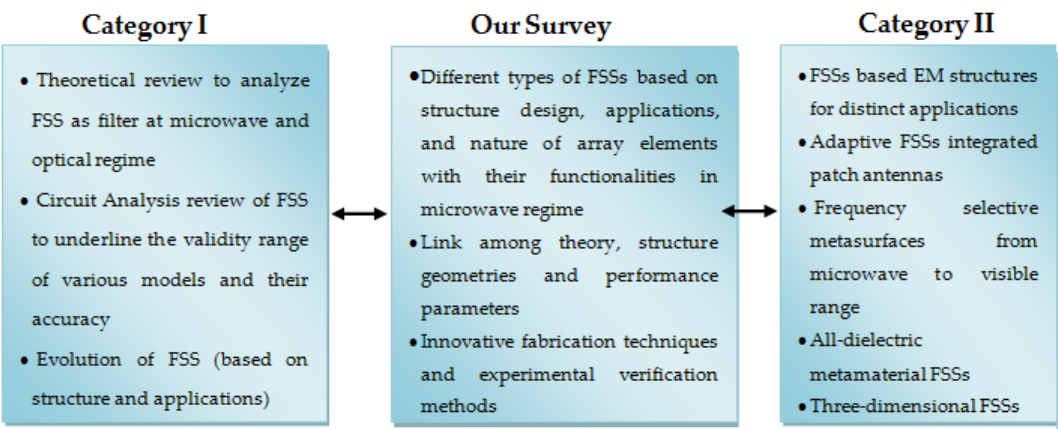
Figure 1. Comparison of the presented survey with previous review articles on